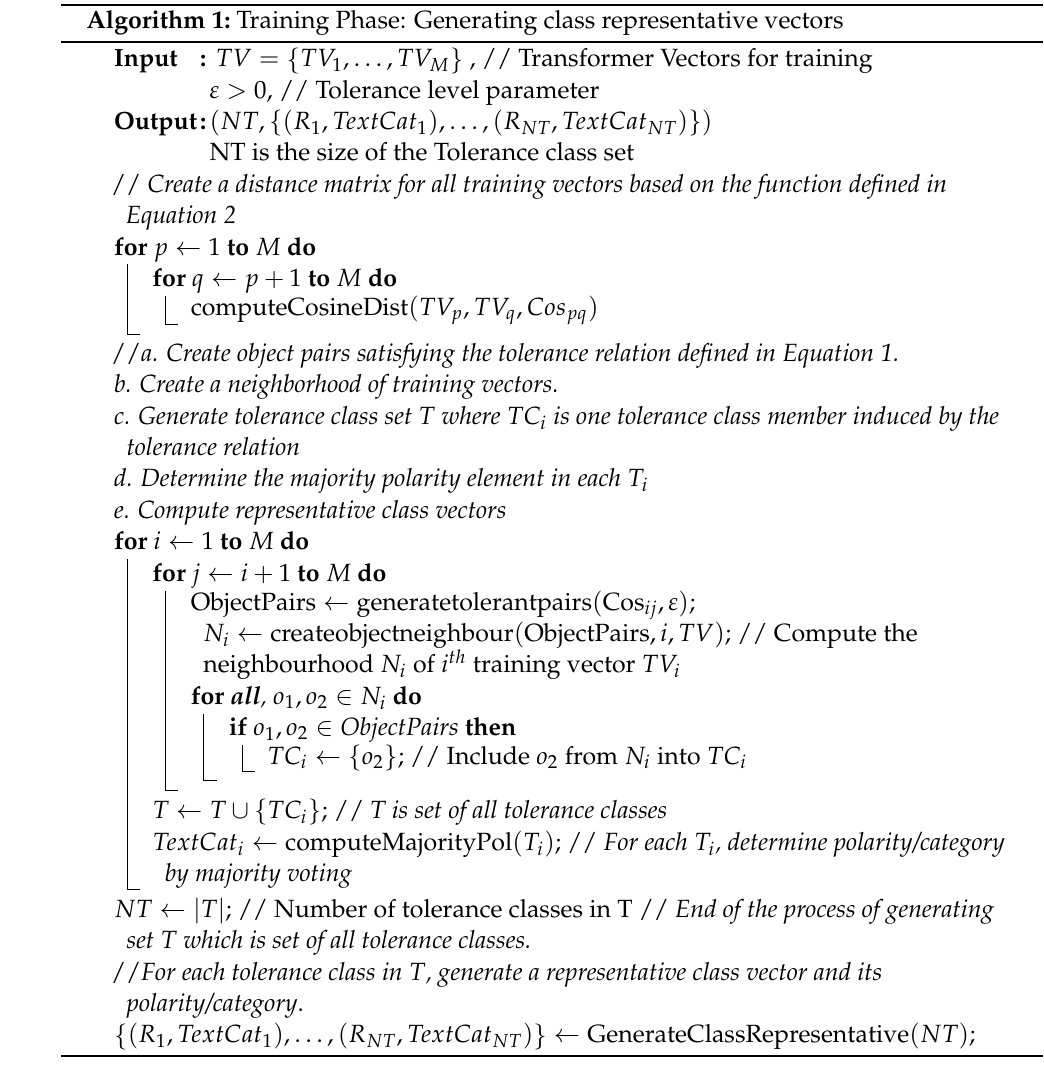
Algorithm 2: Testing Phase: Assigning Sentiment